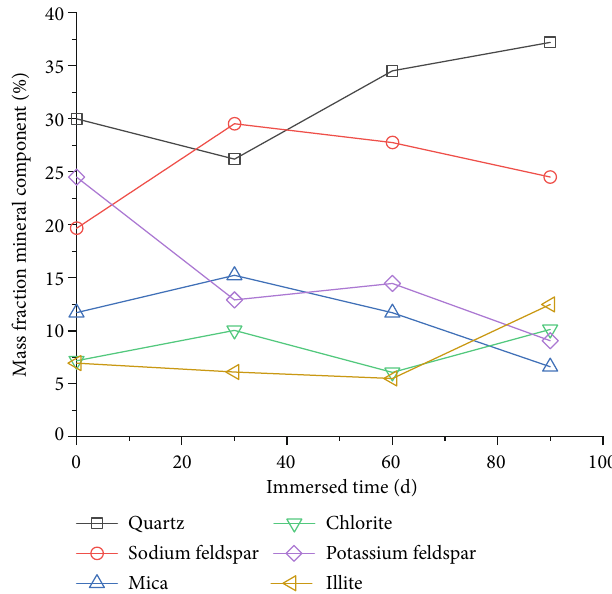
Figure 5: Variation curves of the main mineral content during the immersion